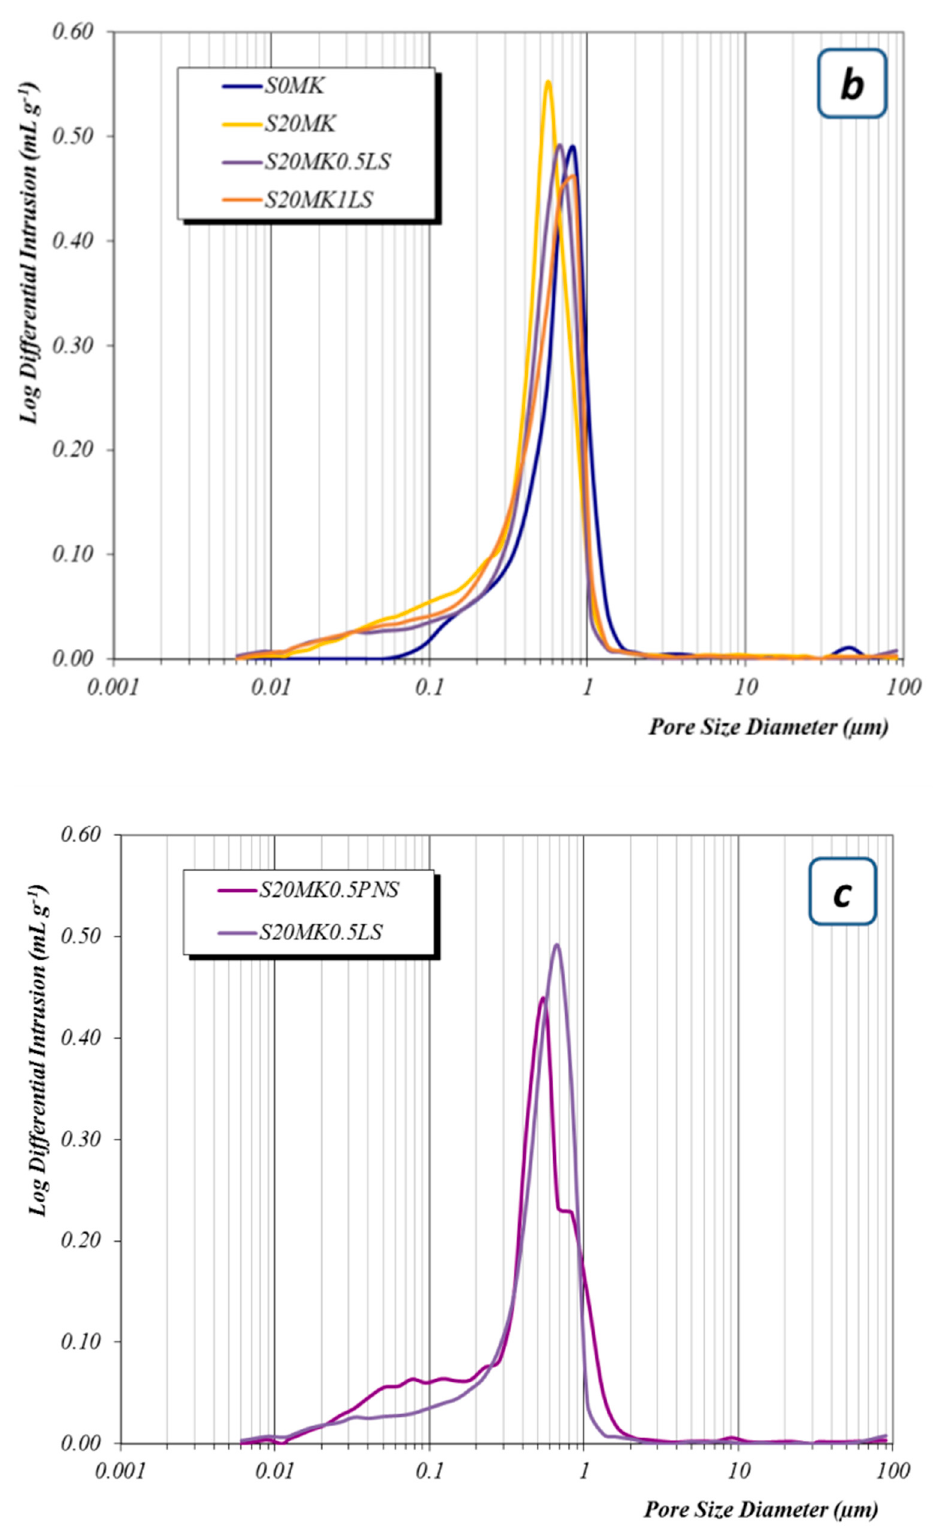
Figure 10. Pore size distribution of different samples tested after 91 curing days. ( a ) control sample, 20 S20MK and samples with PNS, ( b ) control sample, S20MK and samples with LS, ( c ) comparison between samples with 0.5 wt. % of PNS and LS.